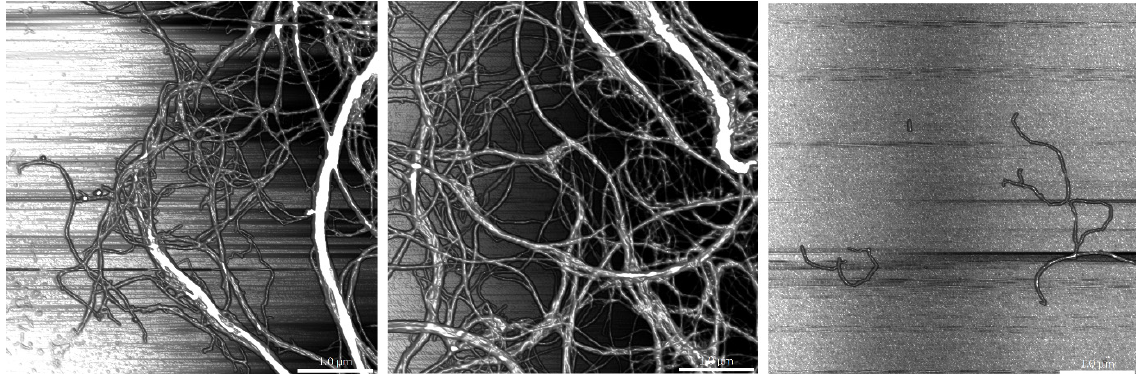
Figure 3. AFM images of the elaborated nanofibers. From left to right: OT, B1 and B2. Scale bar corresponds to 1 μ m.